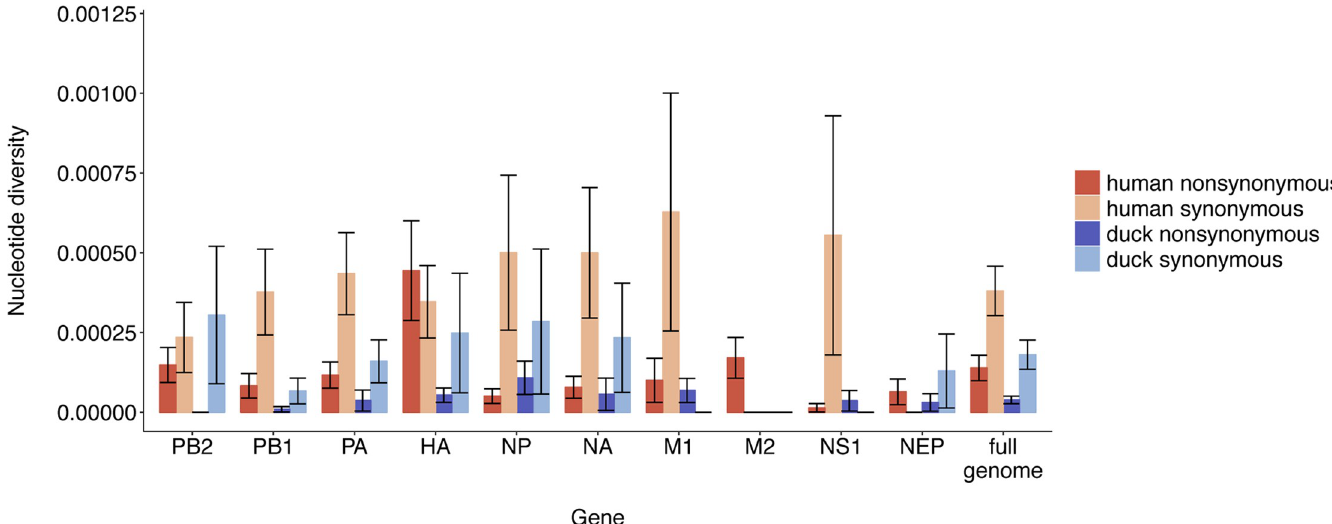
Fig 3. Purifying selection and genetic drift shape within-host diversity. For each sample and gene, we computed the average number of pairwise nonsynonymous differences per nonsynonymous site ( π N ) and the average number of pairwise synonymous differences per synonymous site ( π S ). We then calculated the mean for each gene and species. Each bar represents the mean and error bars represent the standard error calculated by performing 10,000 bootstrap resamplings. Human values are shown in red and duck values are shown in